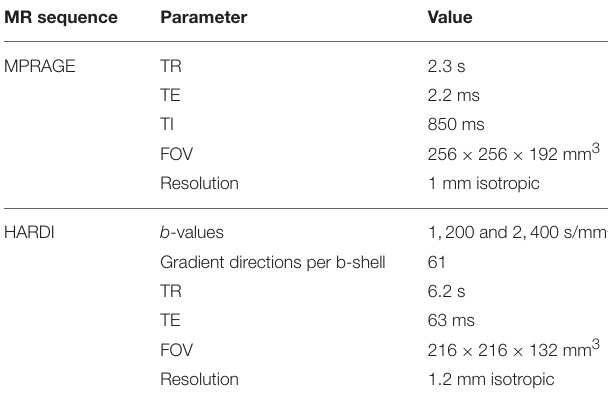
TABLE 1 | MR scanning